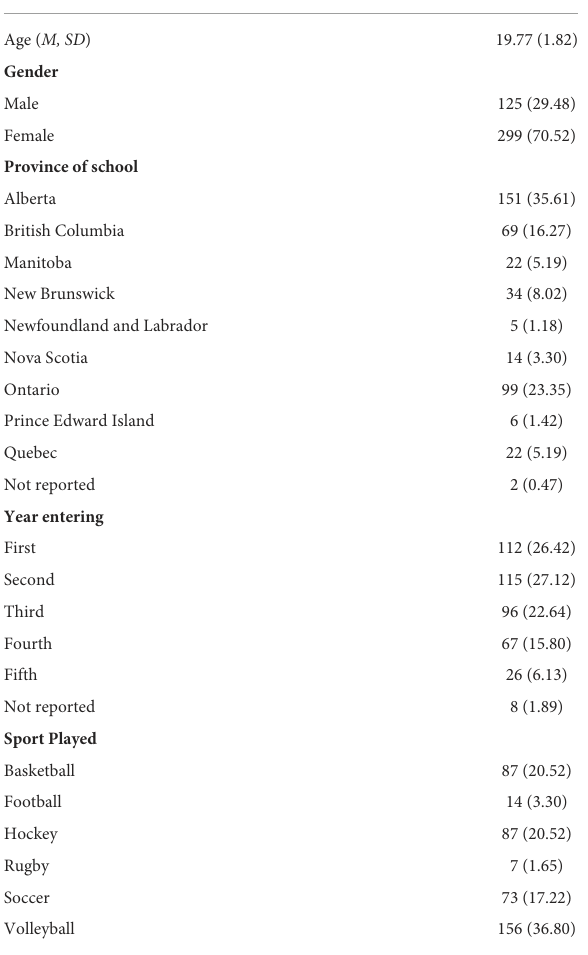
TABLE 1 Characteristics of the